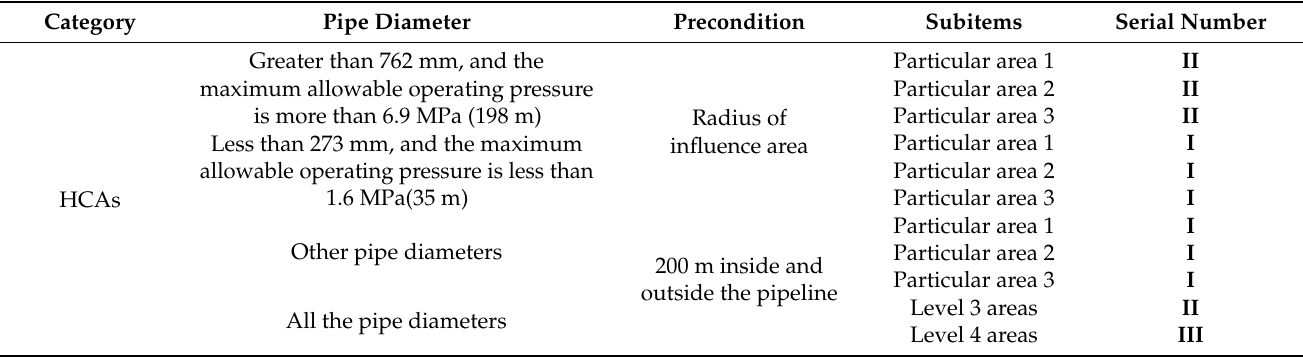
Table 3. Identification principle and grade of HCAs.